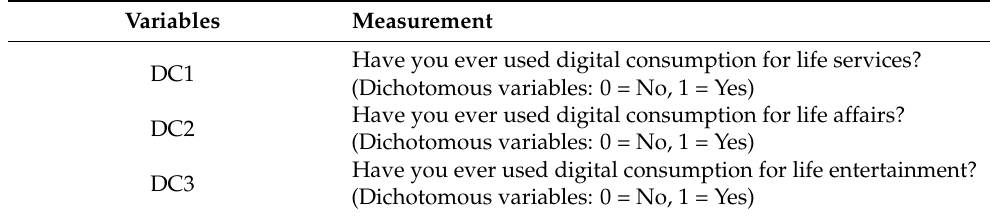
Table 3. Measurements of the independent variable digital consumption (DC).